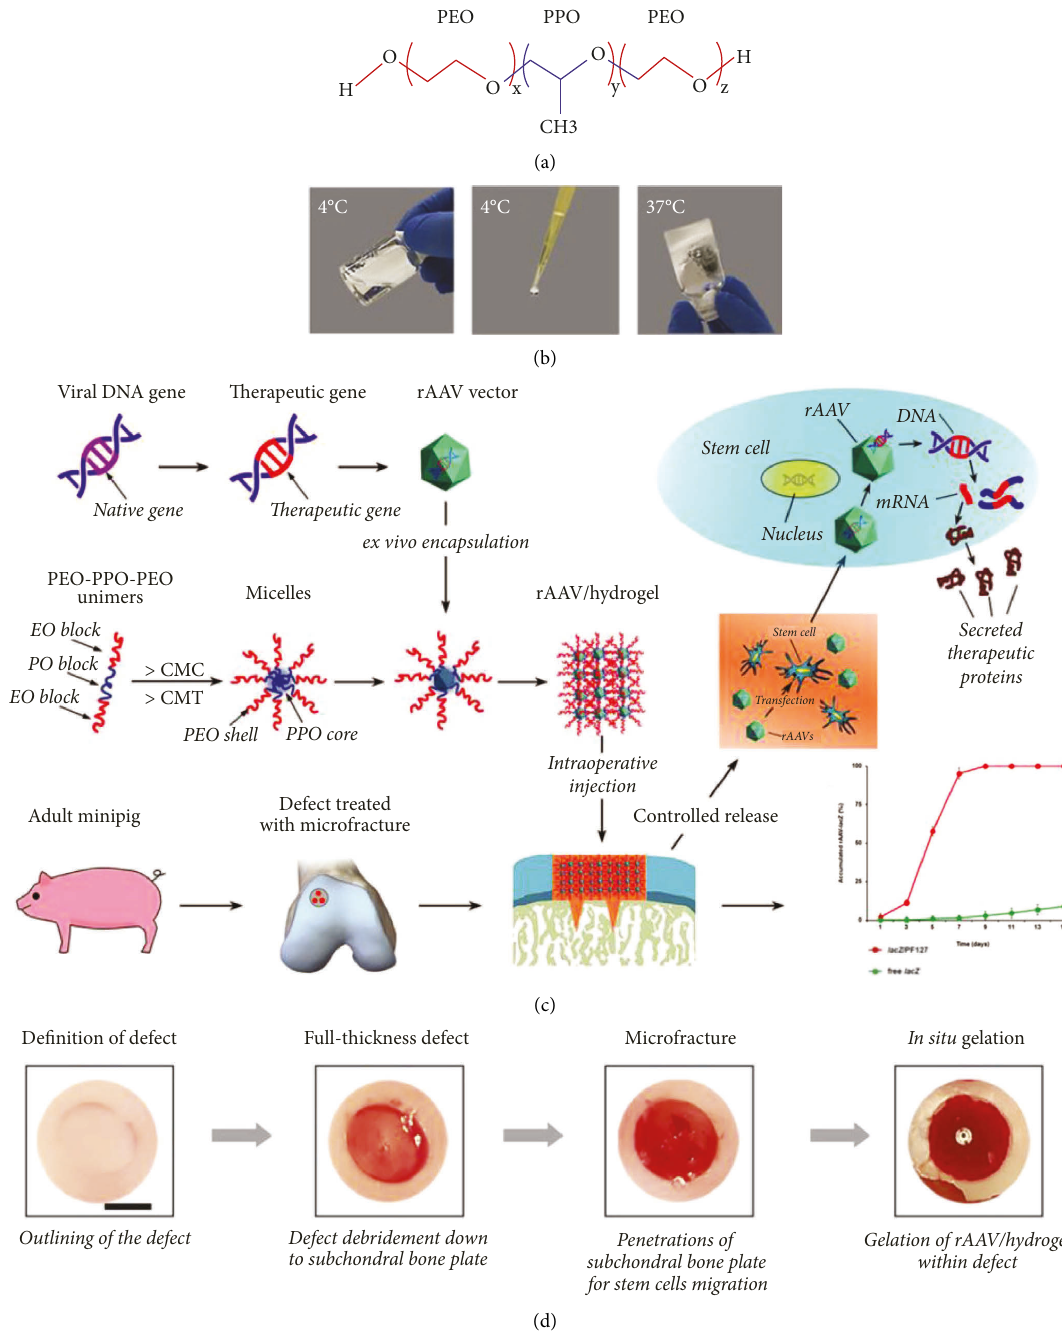
Figure 4: Preparation and application of rAAV-FLAG-hSOX9/PEO-PPO-PEO hydrogel for the treatment of cartilage defects. (a) Structure of the PEO-PPO-PEO (PF127) block copolymer; (b) thermosensitive characteristics of the copolymer (liquid form at 4 ° C and solid form at 37 ° C); (c) flowchart of generation of the rAAV/hydrogel systems for the controlled release of rAAV with implantation in knee full-thickness chondral defects in minipigs following microfracture. The accumulated controlled-release pattern of rAAV from PF127 is presented relative to free rAAV; (d) intraoperative view of the full-thickness chondral defect creation and treatment with microfracture augmented with in situ gelation of the rAAV/hydrogels. Adapted with permission from Madry et al.